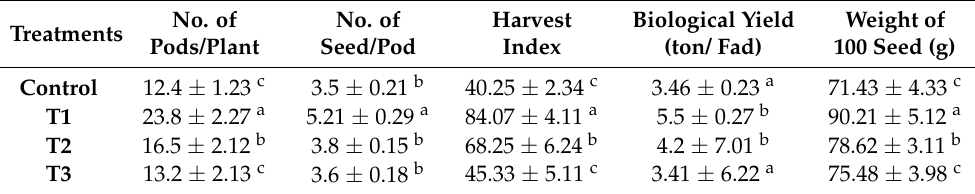
Table 5. Impacts of diverse iron sources (nano, chelate, and sulfate), as foliar spray, on Vicia faba yield and its